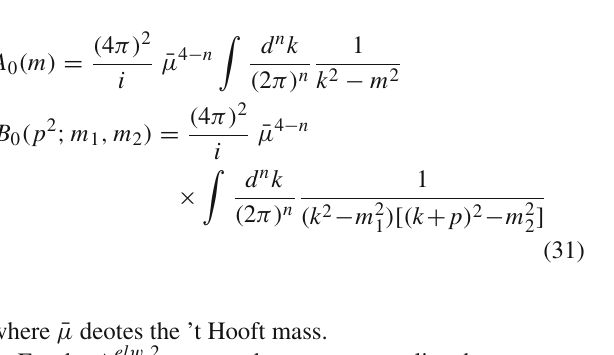
Fig. 6 All possible cross insertions into one of the diagrams contributing to the leading terms of (cid:9) el w, 2 NNLO involving top quarks and